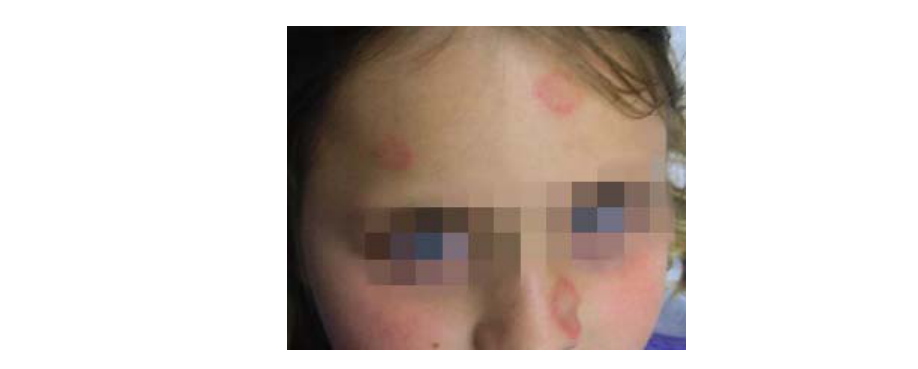
Figure 16. Tinea corporis.